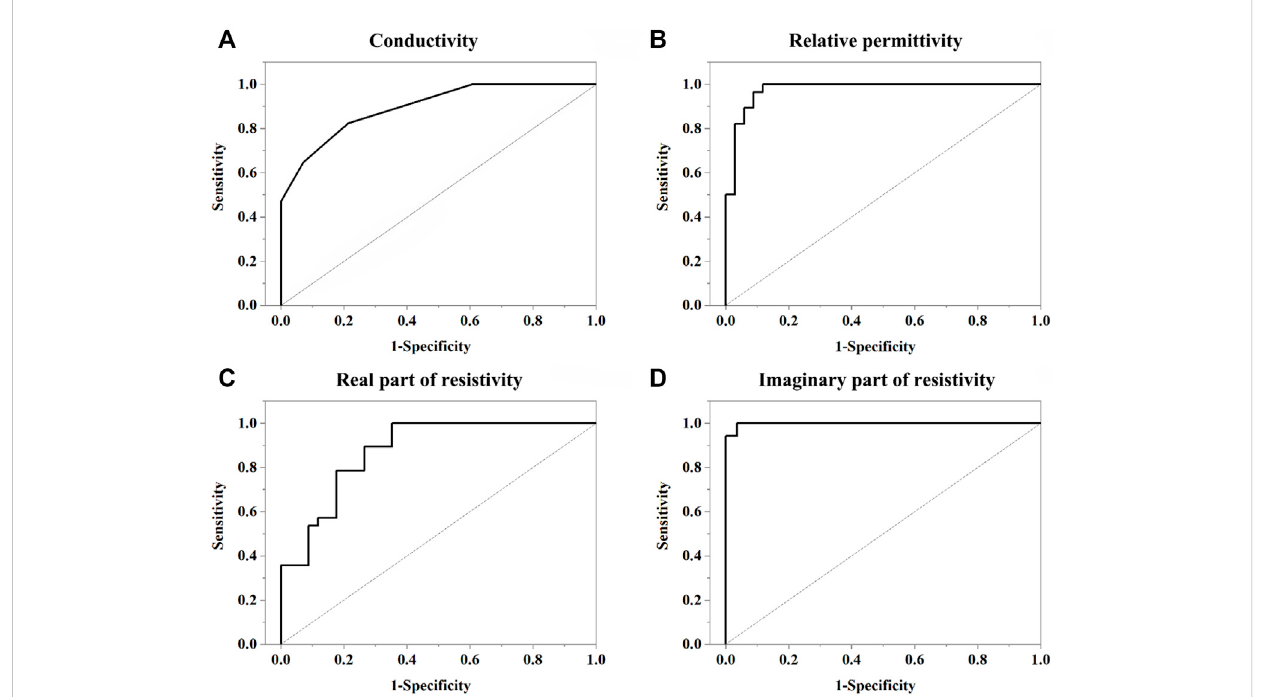
FIGURE 6 Receiveroperatingcharacteristic(ROC)curveofdielectricparameters( σ , ε r ; ρ re ; ρ im )forabilitytopredictRCC. (A) Conductivityat633 Hz. (B) Relative permittivity at 14 kHz. (C) Real part of resistivity at 633 Hz. (D) Imaginary part of resistivity at 10 kHz. The areas under the ROC curve (AUC) of σ , ε r , ρ re and ρ im were 0.896, 0.975, 0.876, and 0.997 for RCC prediction, respectively. The sensitivity and speci respectively.